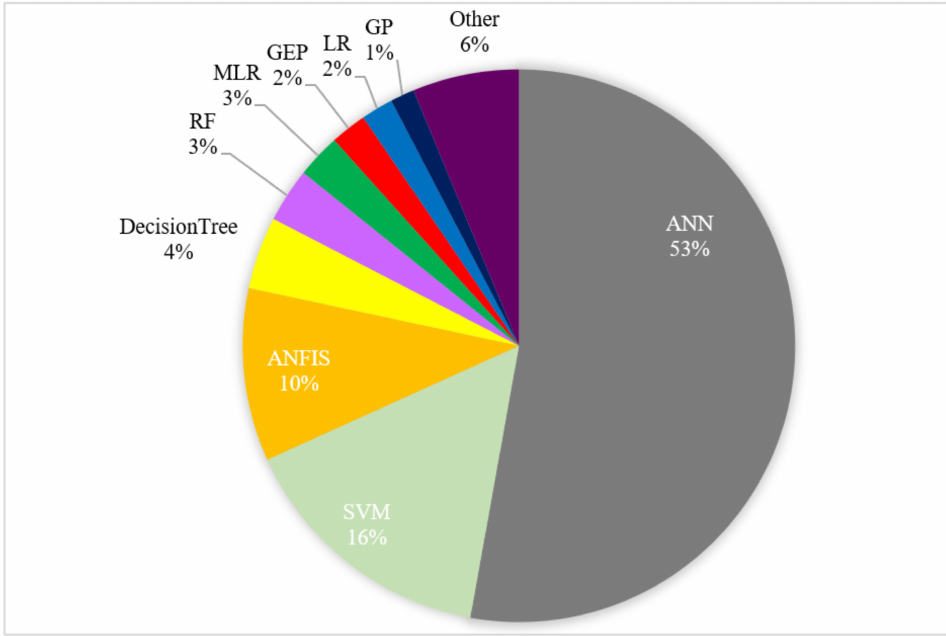
Figure 5. The proportion of the reports according to the ML method that they have